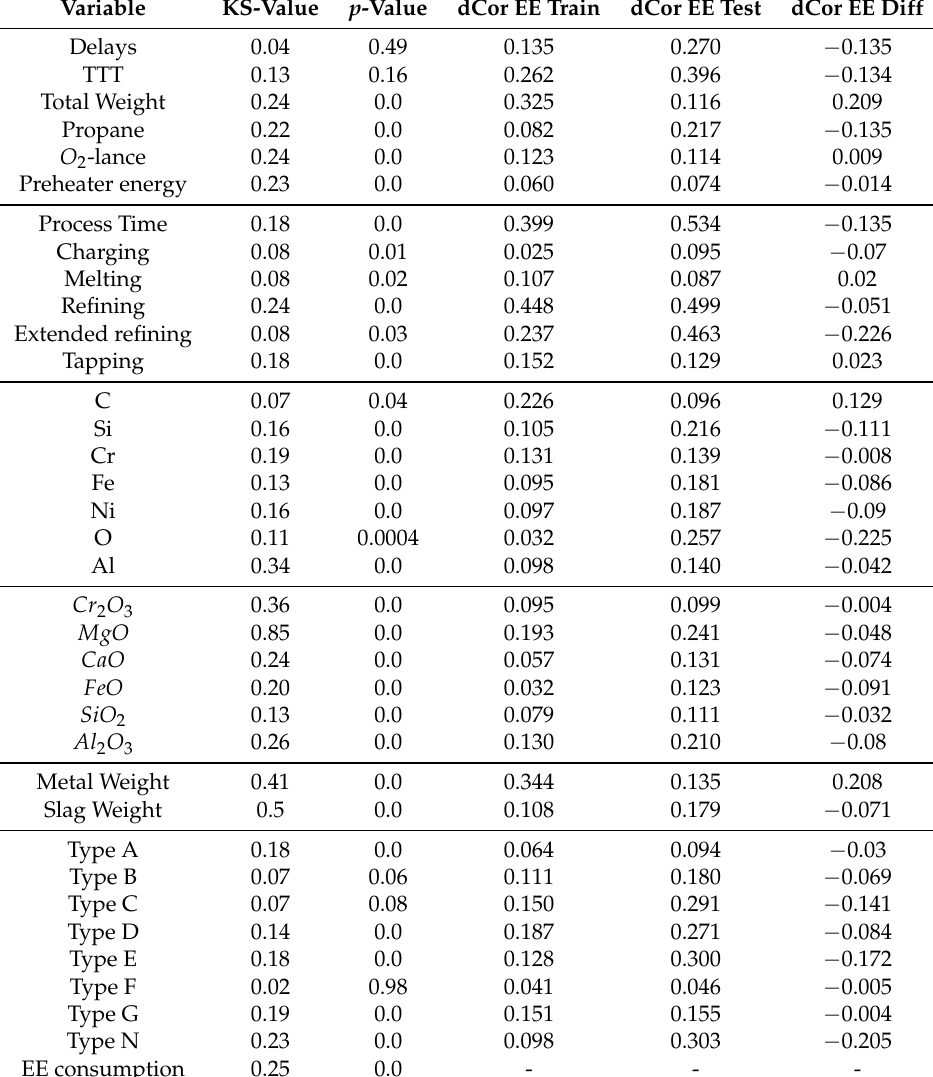
Table 12. Two-sample KS tests for the training data against the test data for all input variables and the EE consumption. Distance correlation (dCor) for training and test data sets are calculated as a one-to-one correlation between the input variables and EE consumption. The difference in dCor is defined as dCor ( training ) − dCor ( test ) .